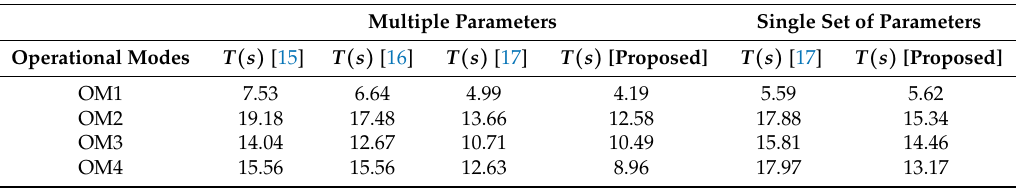
Table 14. Total operation time for each